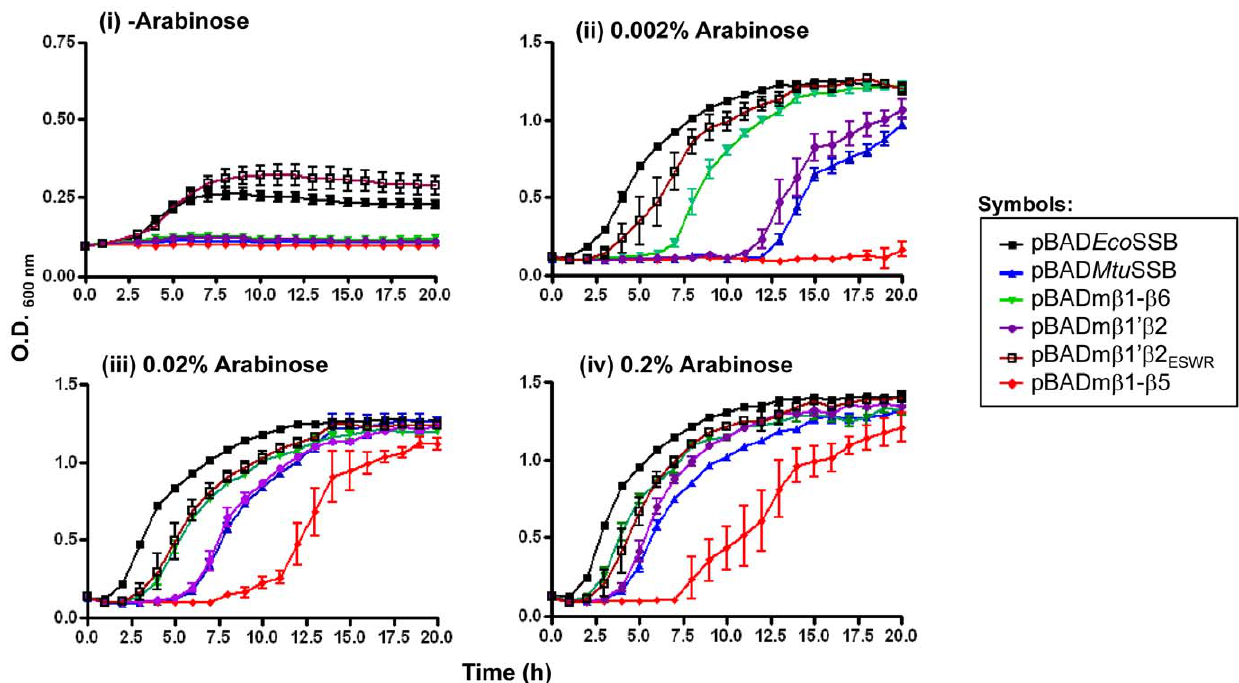
Figure 7. Growth of E.coli RDP317 ( D ssb::kan ) supported by various SSBs in the absence (panel i) or presence of 0.002, 0.02 or 0.2% arabinose (panels ii–iv, respectively). Averages ( 6 SEM) of the growth of three independent colonies are plotted.